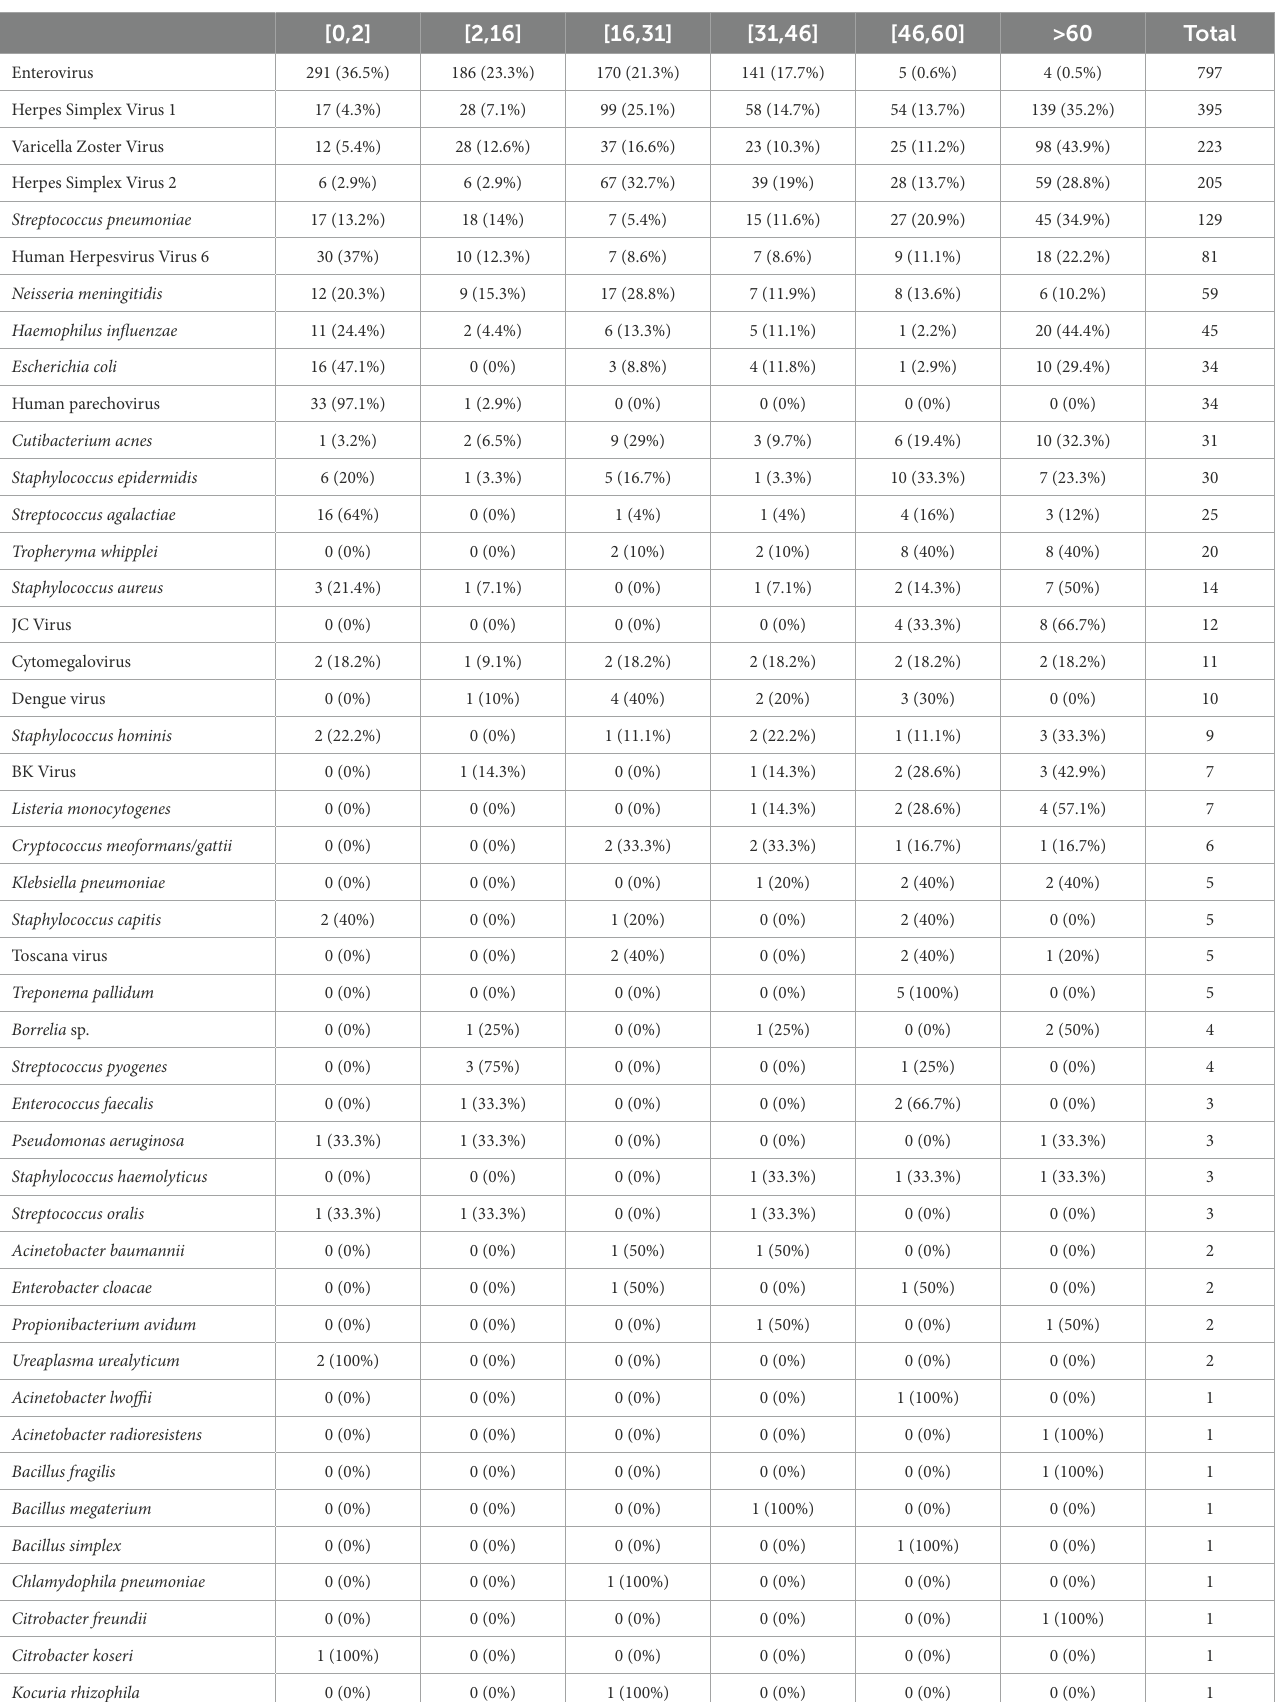
TABLE 2 Prevalence of pathogens by age for the period spanning from December 2014 to December 2019 (Data gathered from Nîmes and